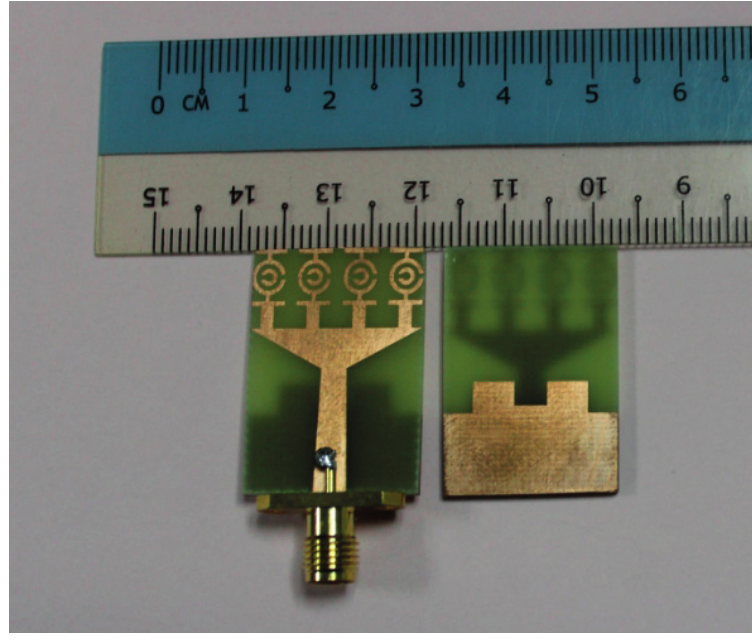
Figure 13. Photograph of the fabricated UWB MTM